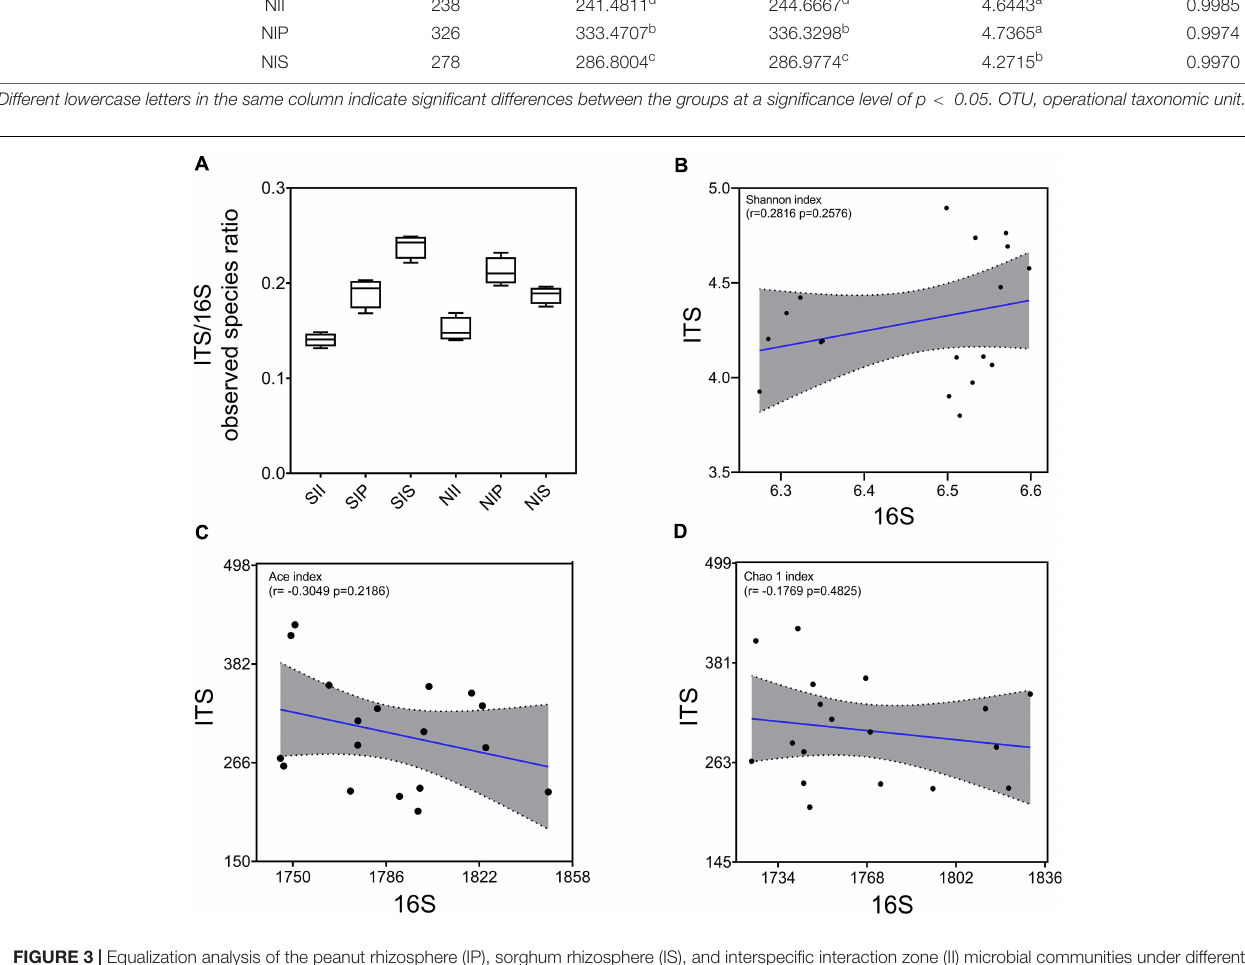
FIGURE 3 | Equalization analysis of the peanut rhizosphere (IP), sorghum rhizosphere (IS), and interspecific interaction zone (II) microbial communities under different soil conditions (S, 0.25% salt-treated soil condition; N, normal soil condition). (A) Ratio of bacterial and fungal operational taxonomic units (OTUs). (B) the correlation between bacterial and fungal Shannon indices. (C) the correlation between bacterial and fungal Ace indices. (D) the correlation between bacterial and fungal Chao1